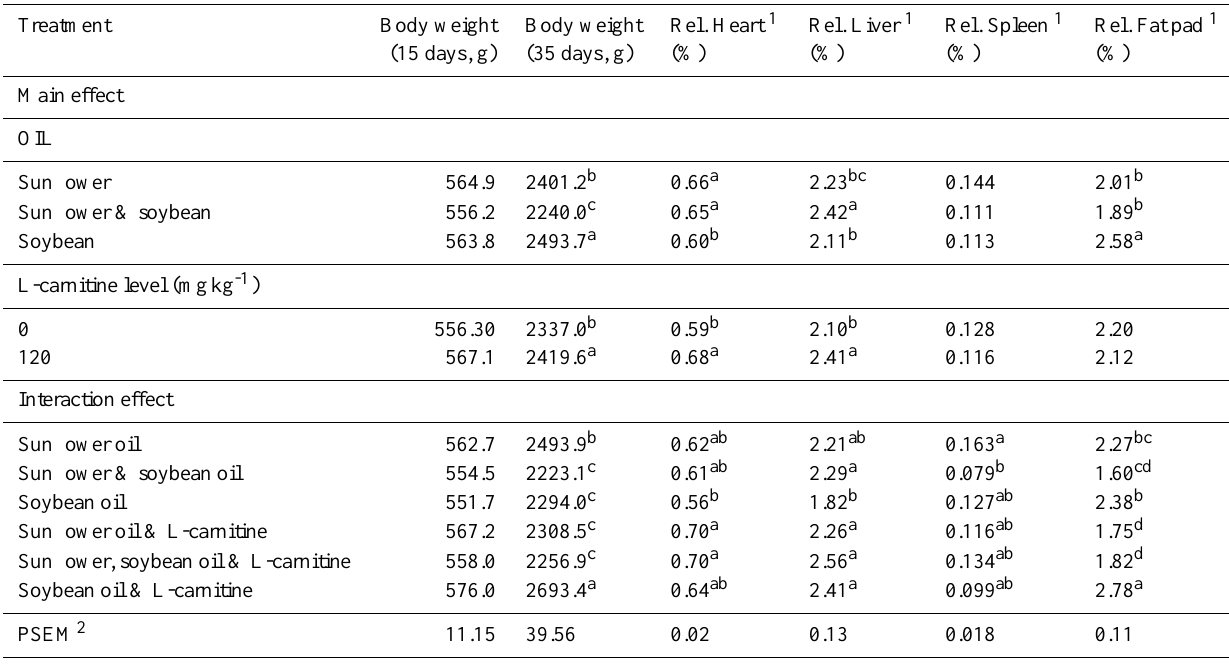
Table 4. Effects of dietary oil sources and L-carnitine supplementation on mean body weight (15 and 35 days old) and relative weight of the internal organs to the live bodies (35 days) of broiler